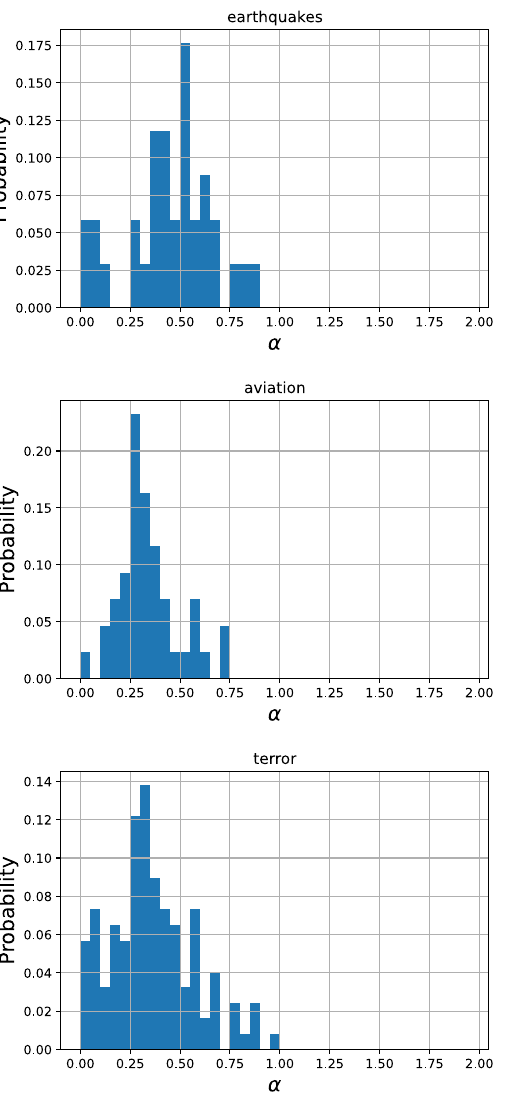
five categories. Most of the samples fall within a certain range ( 0 < α < 1 ) and show similar values ( α ∼ 0.3 ) independent of the